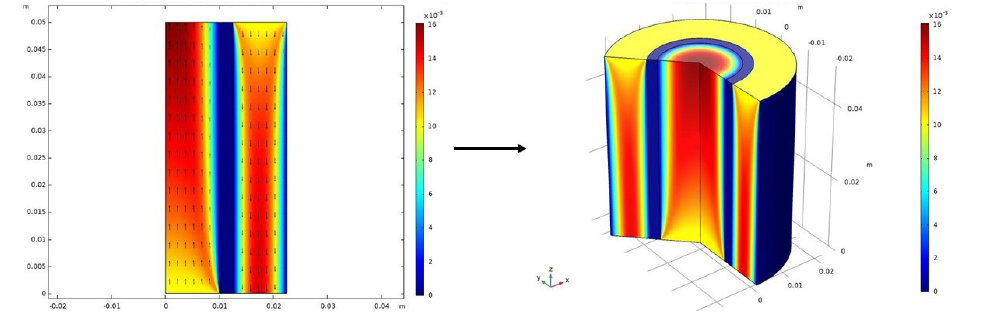
Figure 8. Velocity profiles in a counter-flow, gas-liquid HFMC. The liquid flows on the tube-side, entering at z = L , and the gas enters the shell-side at z = 0. This 2D-axisymmetric model resolves properties in a 2D cross-section ( left ), then revolves those results around the z-axis to form a 3D plot (cid:114) ( right ). These images were produced using COMSOL Multiphysics 5.5.